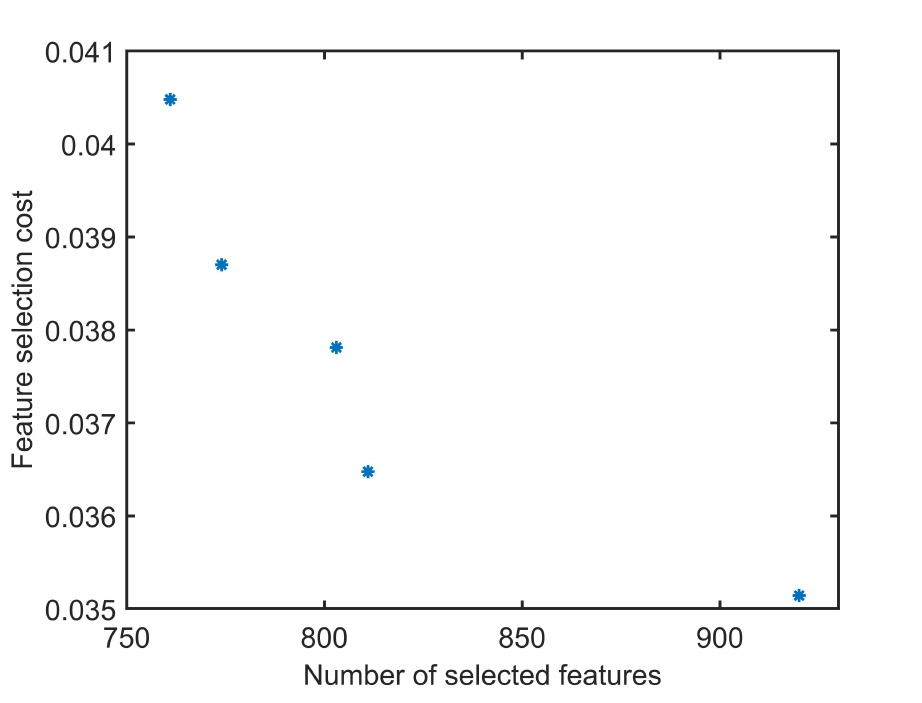
Figure 8. Pareto-front of the NSGA II.